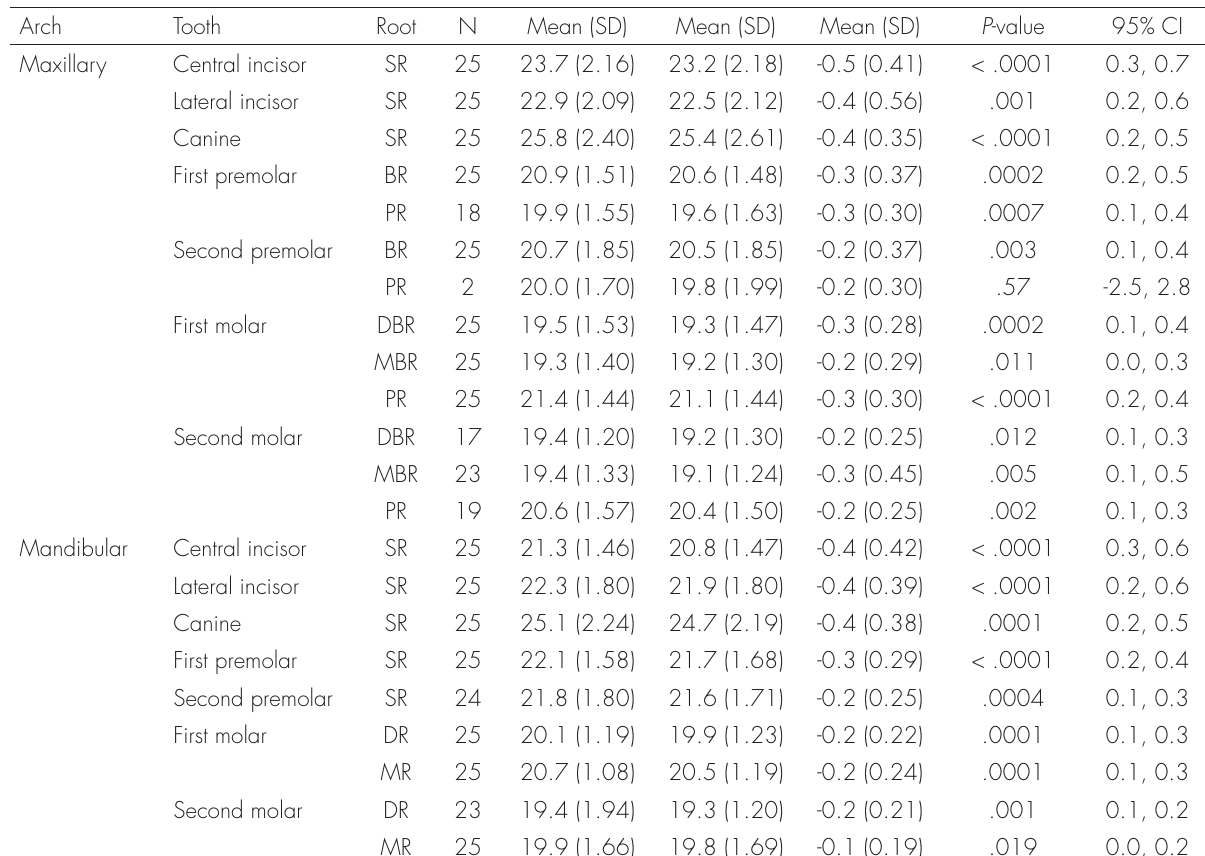
Table II. Tooth length averaged across side for pre- and post-treatment by root type.